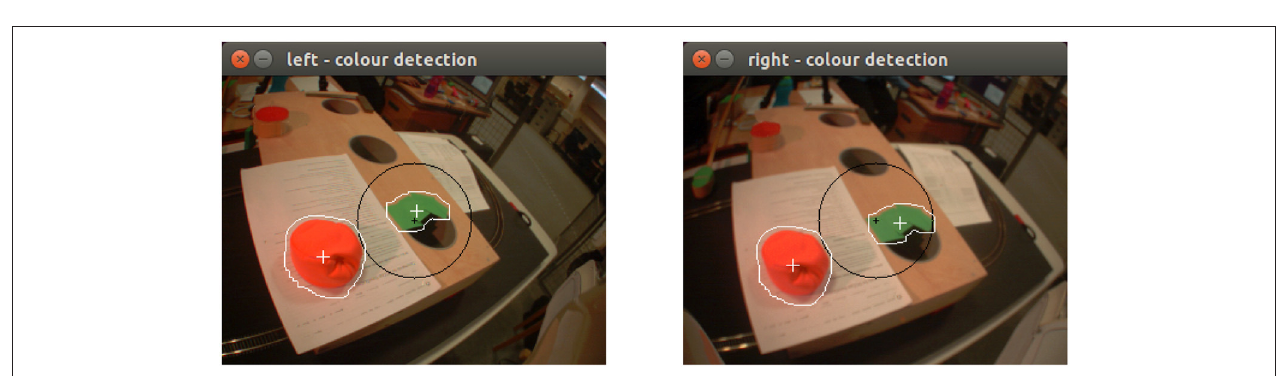
FIGURE 11 | Perceived color patches by the iCub form the left and the right eye.